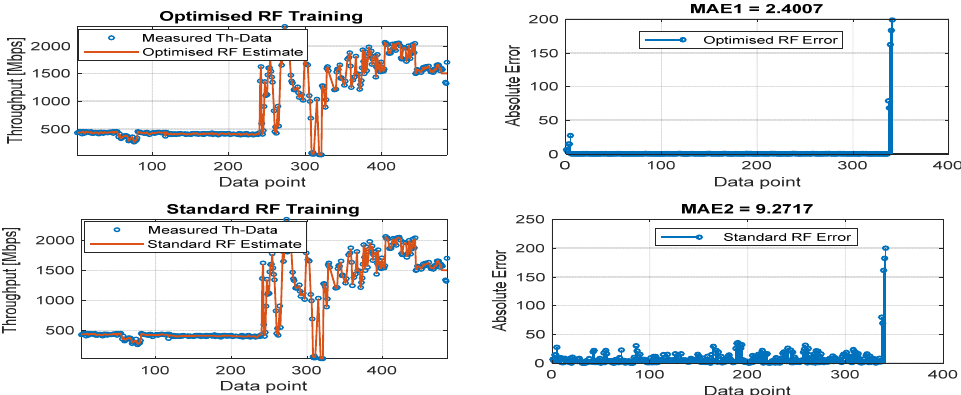
Figure 8. Predicted throughput quality performance of the proposed RF-LS-BPT model and standard RF model at 25 m distance.